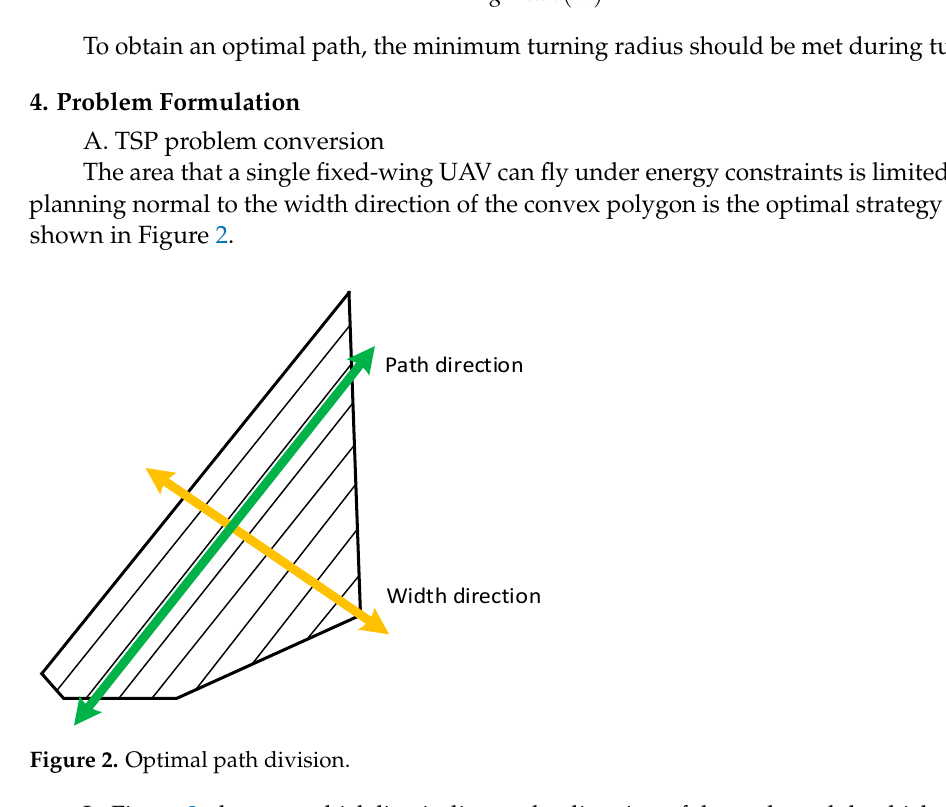
Figure 1. Kinematic parameters and variable description of the UAV.